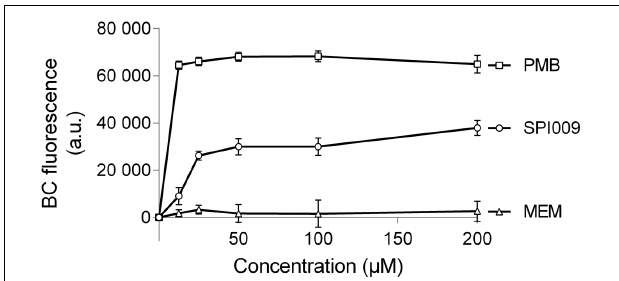
FIGURE 7 | SPI009 interacts with the LPS layer. BC bound P. aeruginosa cultures were treated with equimolar amounts of SPI009, polymyxin B (positive control; PMB) and meropenem (negative control; MEM). Fluorescence was measured continuously, using λ ex = 580 nm and λ em = 620 nm, and corrected for background fluorescence. Results represent the average of four independent repeats ± SEM with BC fluorescence values obtained after 1 h.